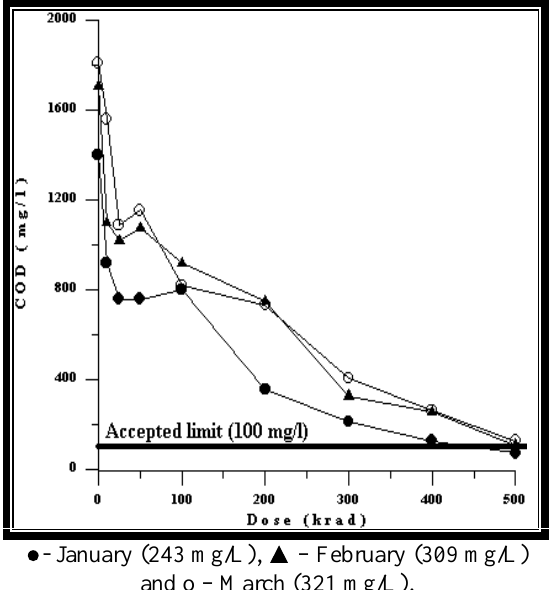
Figure 8: TSS concentration values of irradiated sample of wastewater for BOD 5